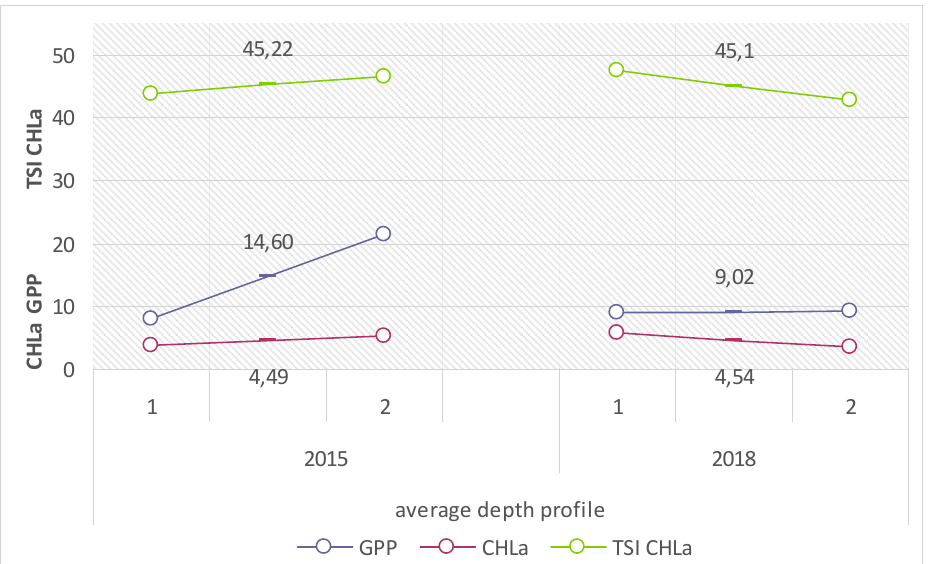
Figure 8. Mean values with ranges of biological indicators of the trophic status of pelagial